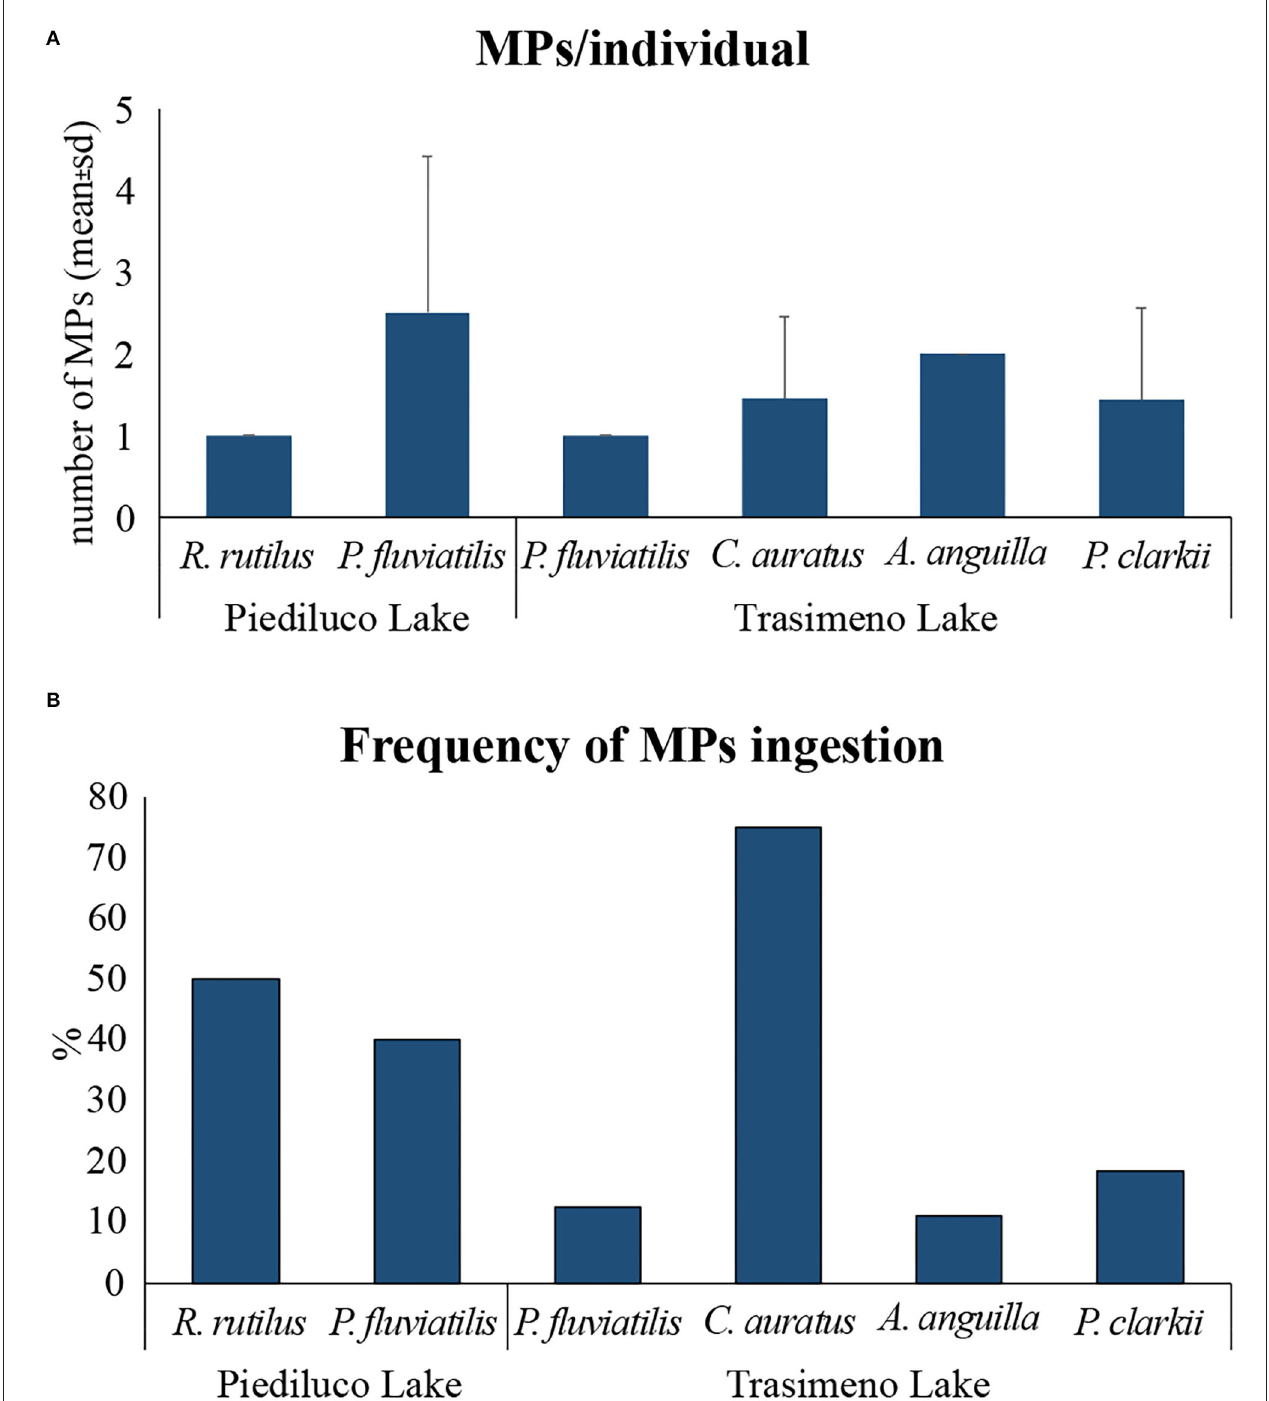
FIGURE 2 | MPs extracted from the gastrointestinal tract of fishes and from the whole soft body of crayfishes sampled in Piediluco and Trasimeno lakes: (A) number of ingested MPs per individual (mean ± sd), (B) frequency of MPs ingestion (%).